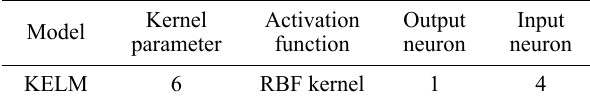
Table 6 KELM model